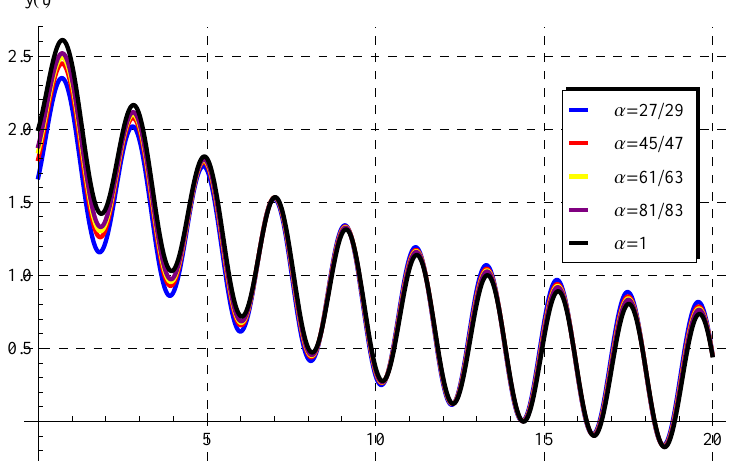
Figure 4. Graphs of the solution (47) at a = 1, b = 1, A = 2, ω = 1